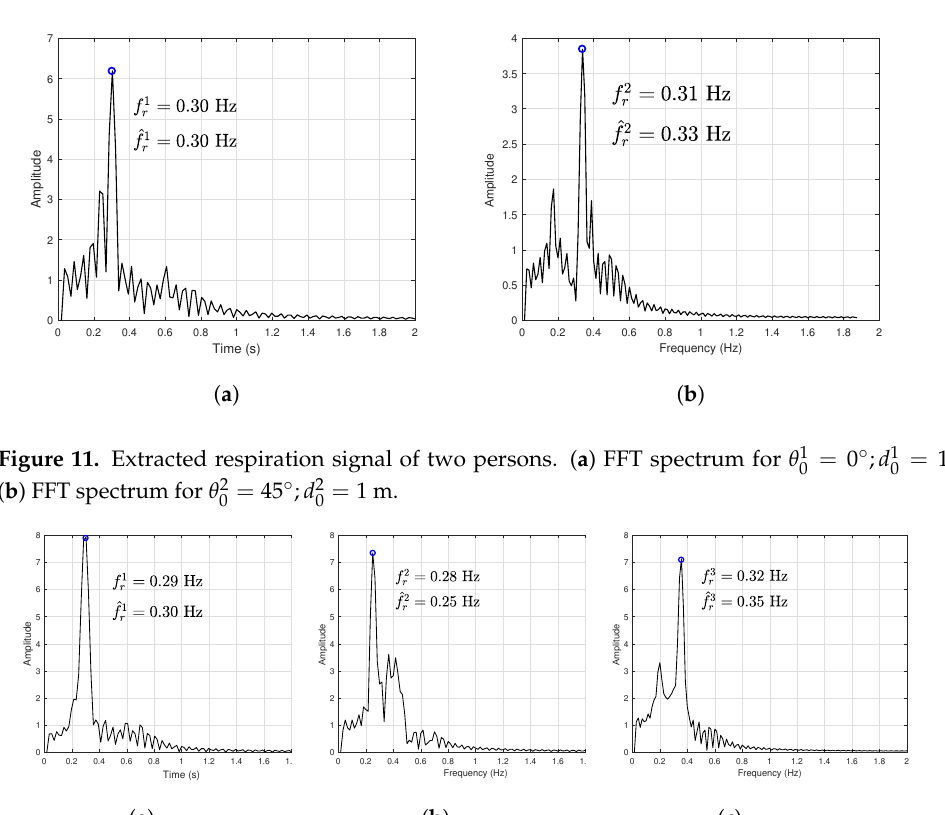
= − 30 ◦ ; d 1 = 1 m. 0 0 = 45 ◦ ; d 3 = 1.5 0 0